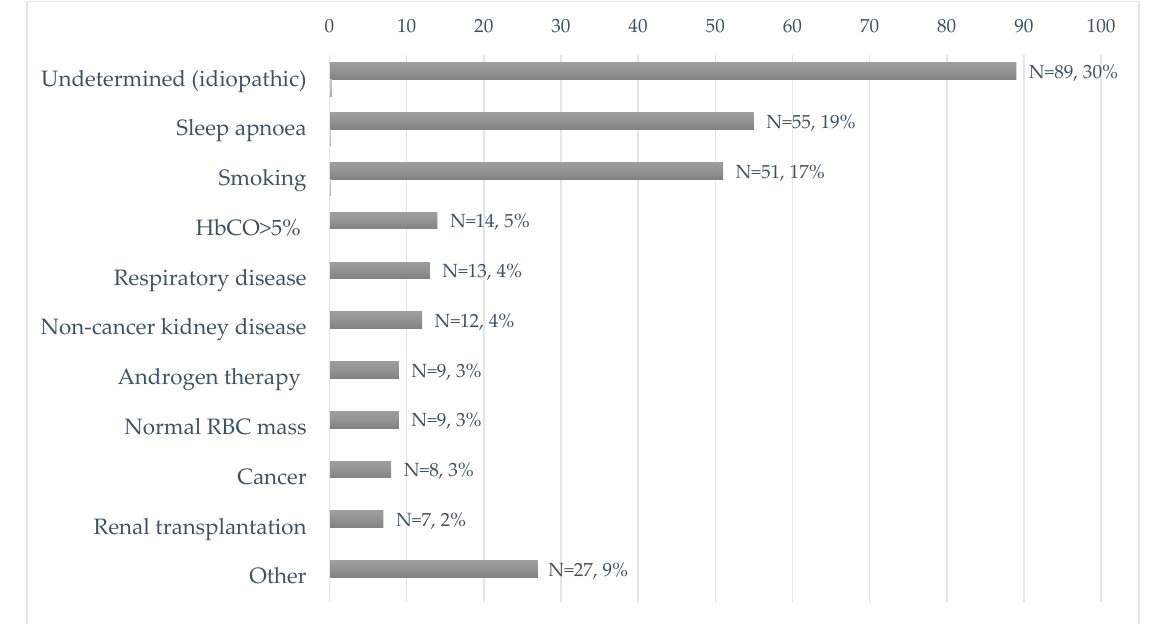
Figure 3. Single causes of JAK2 unmutated polycythaemia (N = 294), according to frequency. The causes of JAK2 unmutated polycythaemia according to the frequency of their 19%), followed by nicotine use (51, 17%), increase in HbCO > 5% (14, 5%), respiratory diseases (13, 4%), noncancer kidney disease (12, 4%), androgen therapy (9, 3%), relative erythrocytosis with normal RBC mass (9, 3%), cancer (renal, adrenal, seminoma, lung, brain) (8, 3%), renal transplantation (7, 2%) and other causes (27, 9%). Congenital erythro- cytosis was identified in 12/294 patients (4%).